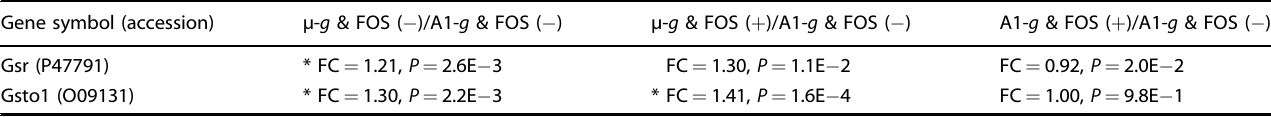
The protein abundance pro fi les of the groups exposed to µ- g with and without FOS ingestion and the group exposed to A1- g with FOS ingestion were individually compared with that of the group exposed to A1- g without FOS ingestion. The results for the proteins, which were categorized as the related factors to glutathione metabolic process, glutathione-mediated detoxi fi cation and/or glutathione redox reactions by DAVID Bioinformatics Resources 6.8 and Ingenuity Pathway Analysis and signi fi cantly ( p < 0.01) affected by µ- g exposure and/or FOS ingestion, in EDL muscles are indicated. The fold change (FC) and p